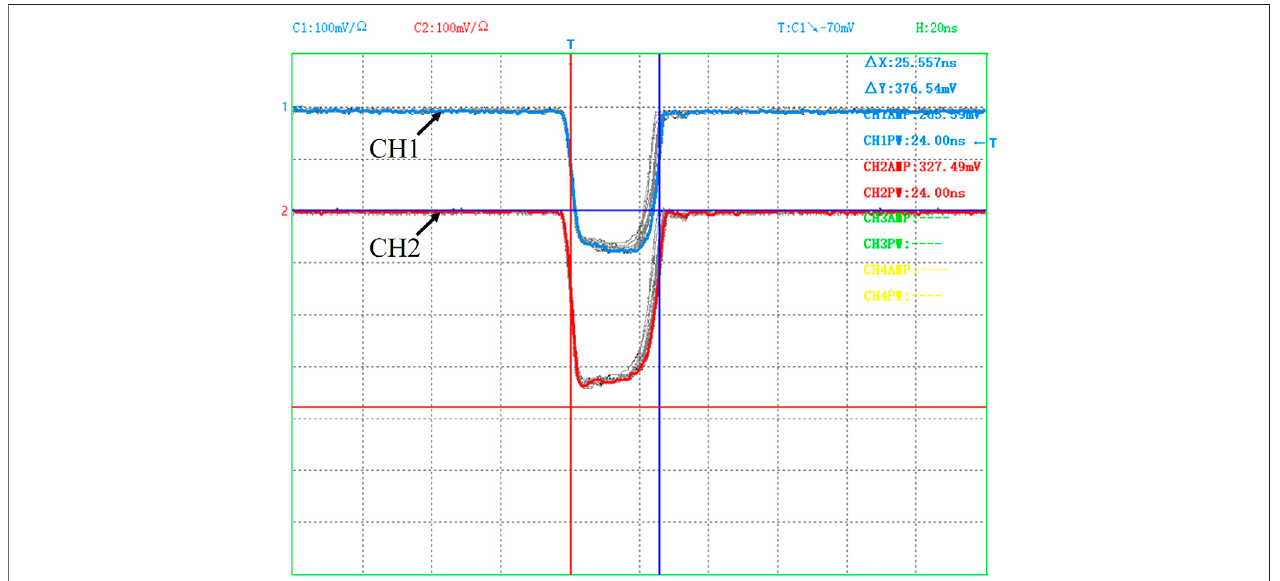
FIGURE 10 | The output waveform of pulse width 20 ns for